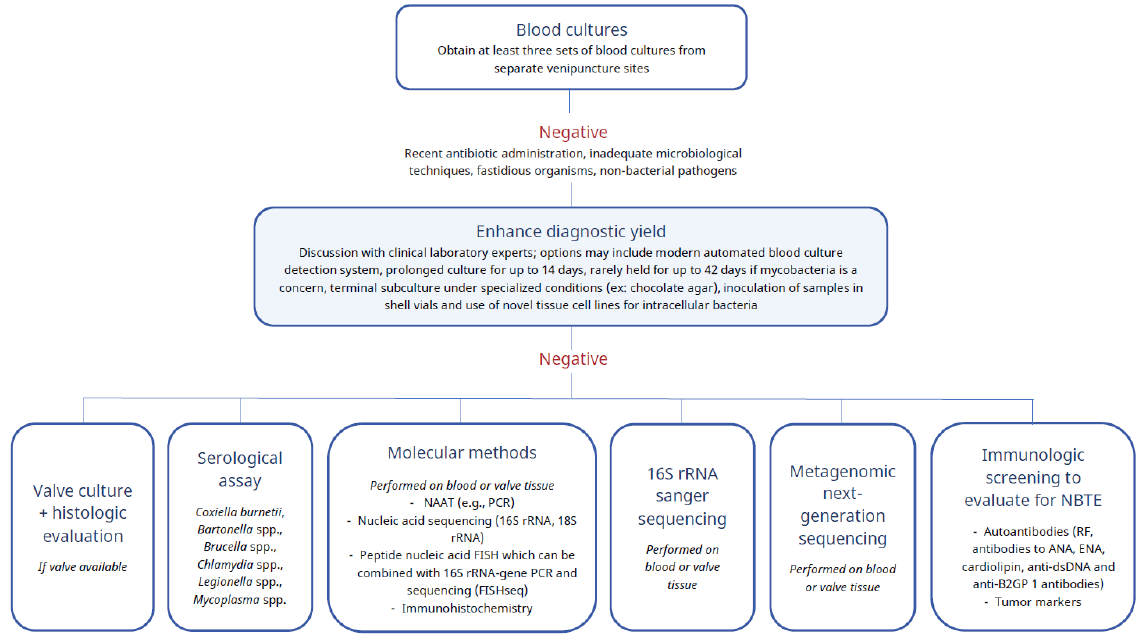
Figure 2. A proposed multimodal laboratory strategy for pathogen identification in patients with blood culture-negative endocarditis. anti-B2GP1: anti-beta-2-glycoproteins; anti-dsDNA: anti-double-stranded DNA; ANA: anti-nuclear antibodies; ENA: extractable nuclear antigens; FISH: fluorescence in situ hybridization; NAAT: Nucleic acid amplification test; NBTE: Nonbacterial thrombotic endocarditis; PCR: polymerase chain reaction; RF: rheumatoid factor; 16S rRNA: 16S ribosomal RNA.